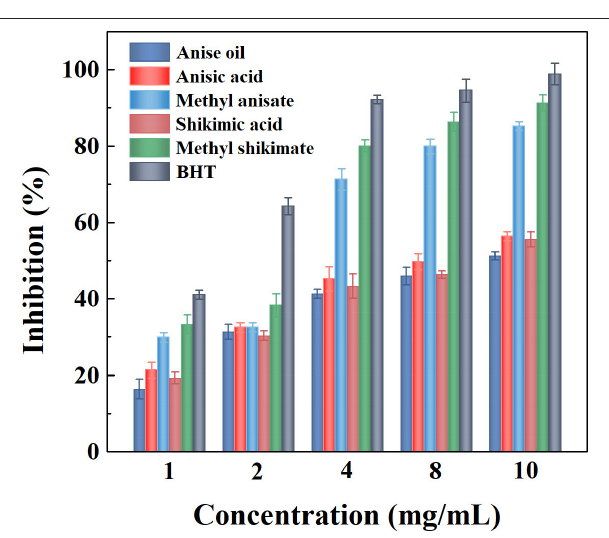
FIGURE 6 | Antioxidant efficacy of anise oil, anisic acid, methyl anisate, shikimic acid, and methyl shikimate.